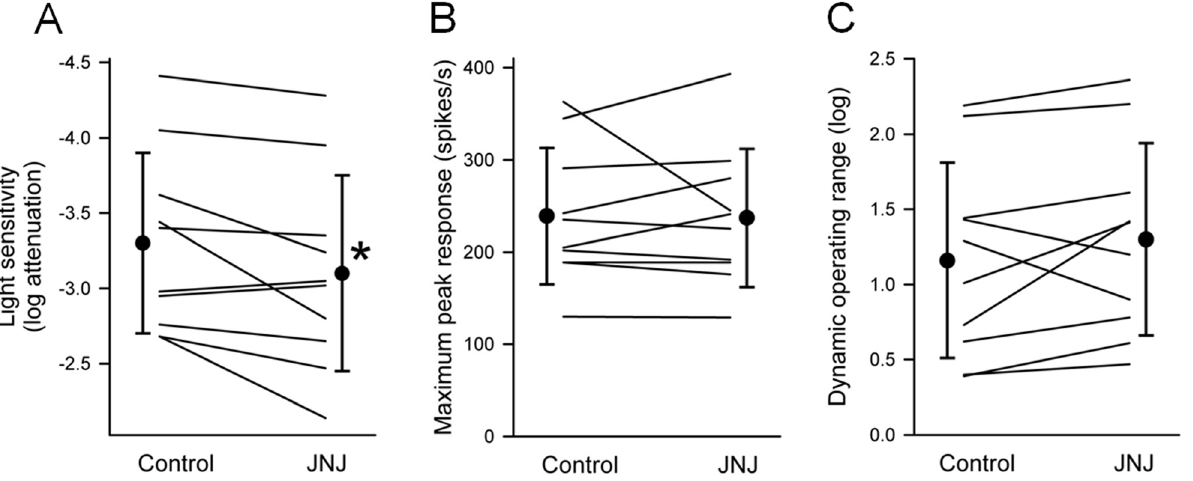
Figure 5. Effects of JNJ16259685 on light responses of ON-center SD rat RGCs. JNJ16259685-induced change in ( A ) light sensitivity, ( B ) maximum peak response, and ( C ) dynamic operating range of SD rat RGCs. Individual RGCs (n=10) are connected by lines. Each circle represents the mean ( 6 standard deviation) value. Asterisk indicates significantly different from control (P , 0.05).